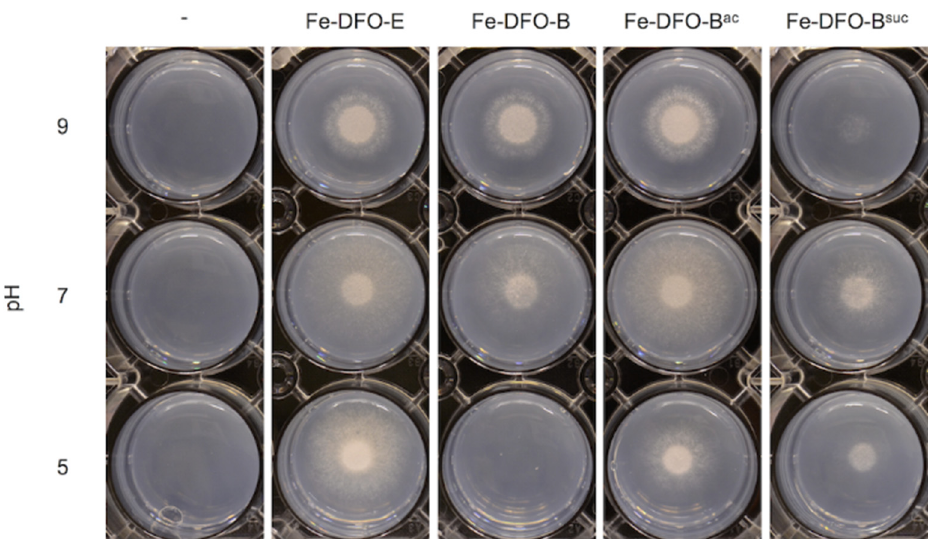
Figure 4. The growth promotion activity of Fe-DFO-B depends on the ambient pH and can be modulated by chemical derivatization. In total, 10 4 spores of A. fumigatus strain ∆ sidA/ ∆ ftrA were point-inoculated on the solid minimal medium with the indicated pH, lacking (-) or containing 0.1 µ M of the indicated iron-loaded siderophore. Plates were incubated for 48 h at 37 ◦